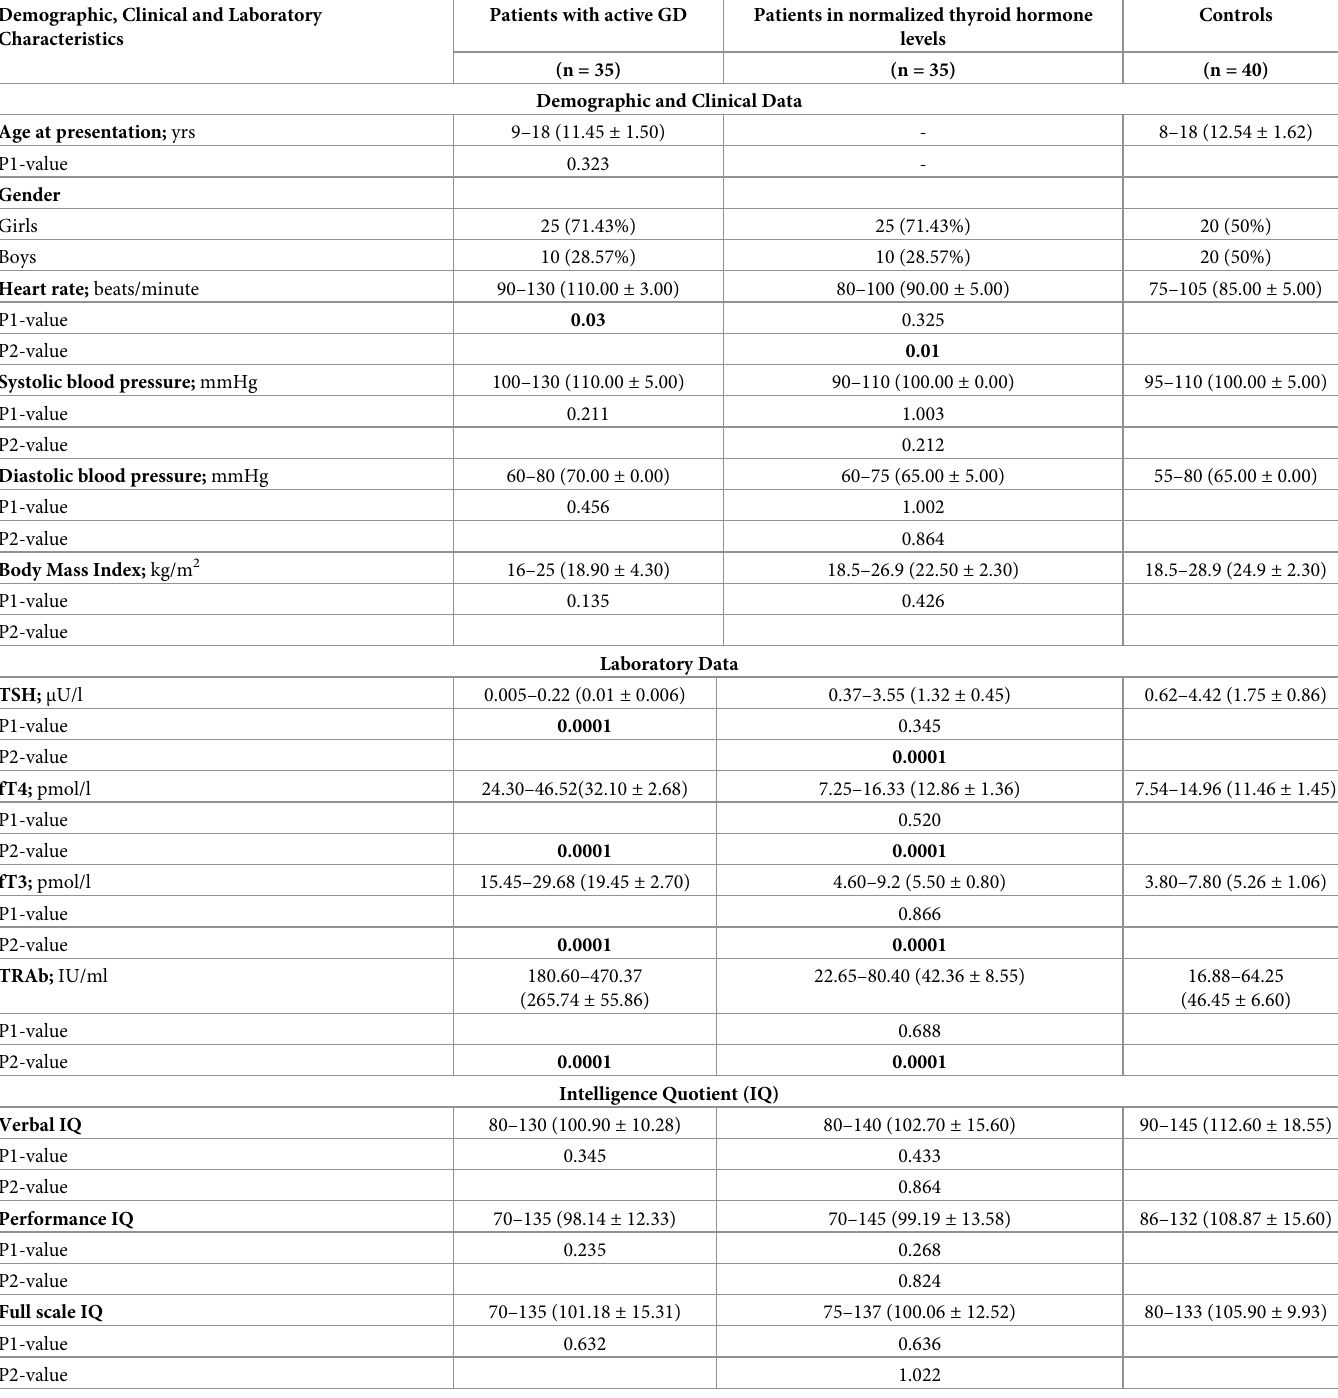
Table 1. The demographic, clinical and laboratory characteristics of the studied groups. Demographic, Clinical and Laboratory